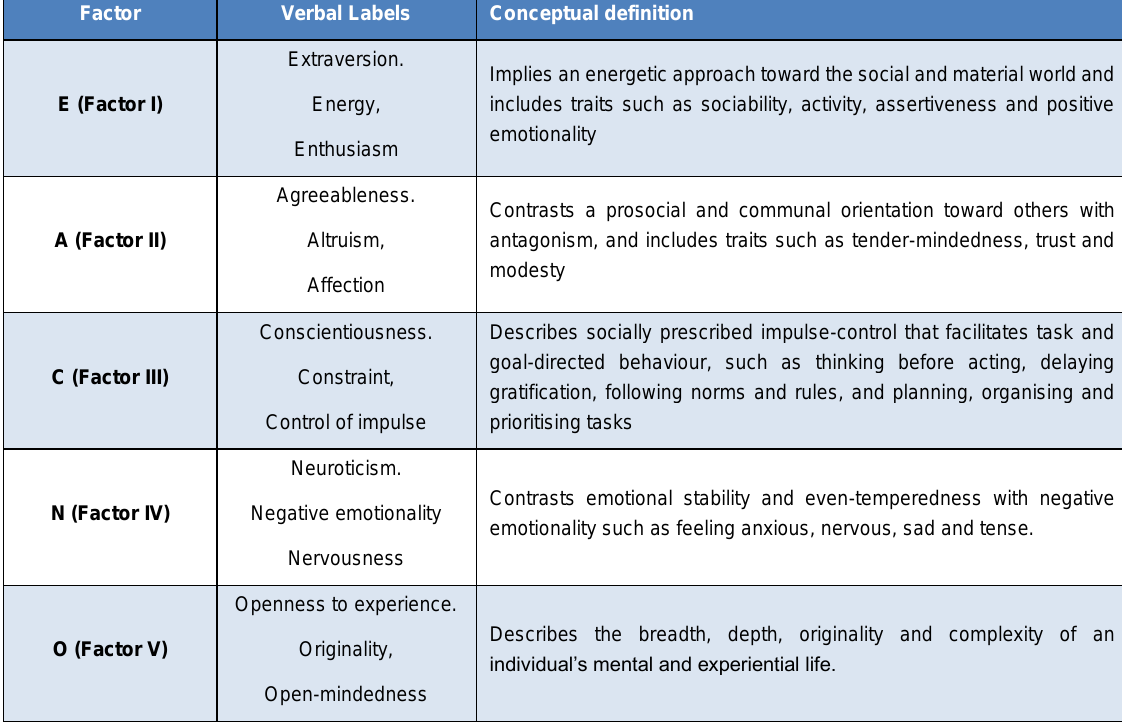
Table 1: Big Five factor model of personality (John et al, 2008. p.